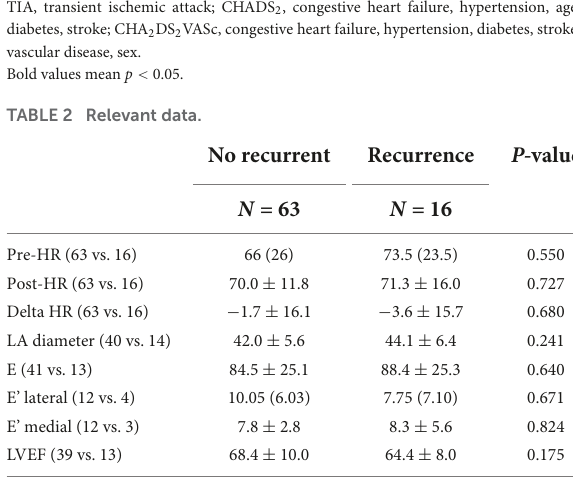
79 patients had recurrent AF after ablation. Diabetes was more prevalent in the recurrence group ( p = 0.045) and patients with recurrence had higher CHADS 2 scores. The remaining parameters are listed in Table 2 . Echocardiographic measurements of left atrium size and left ventricular relaxation in both groups were